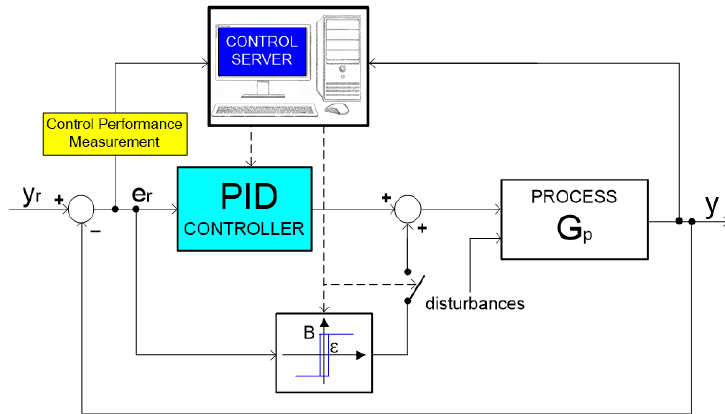
Figure 1. Structure of the control system.